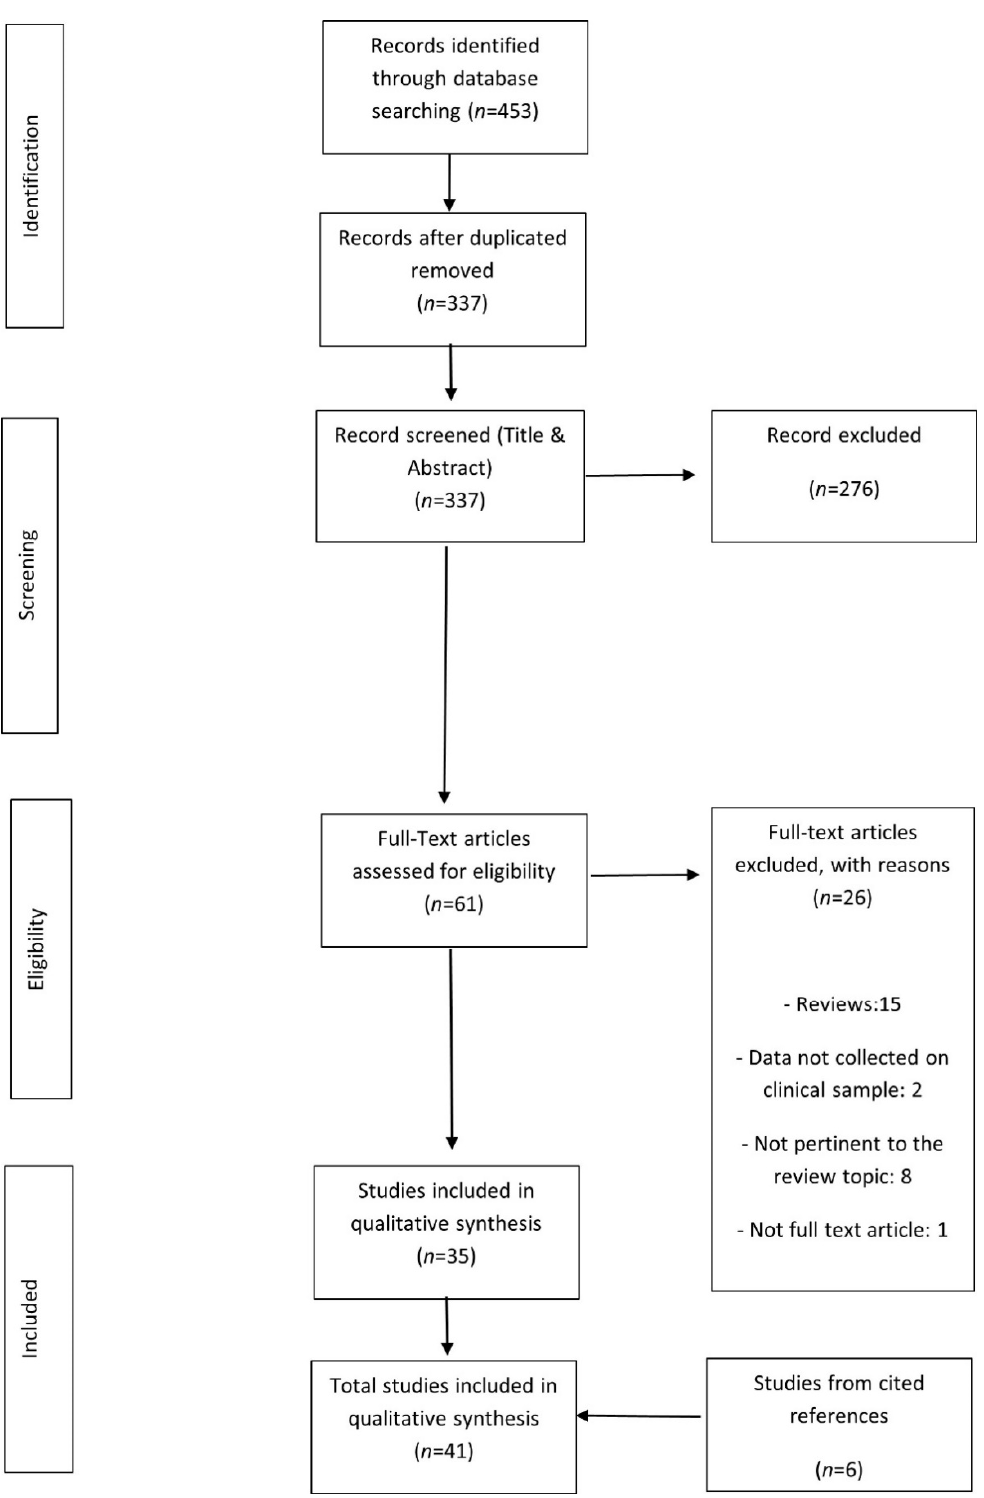
Figure 1. Flow chart for inclusion/exclusion of references. The flow diagram depicts the number of records identified, included and excluded, and the reasons for exclusions.